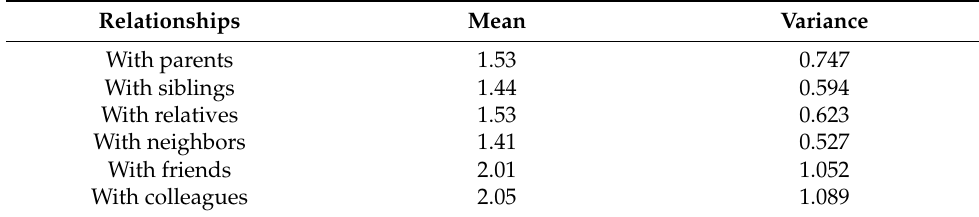
Table 6. Effects of isolation on students’ social relations. Relationships Mean Variance With parents 1.53 0.747 With siblings 1.44 0.594 With relatives 1.53 0.623 With neighbors 1.41 0.527 With friends 2.01 1.052 With colleagues 2.05